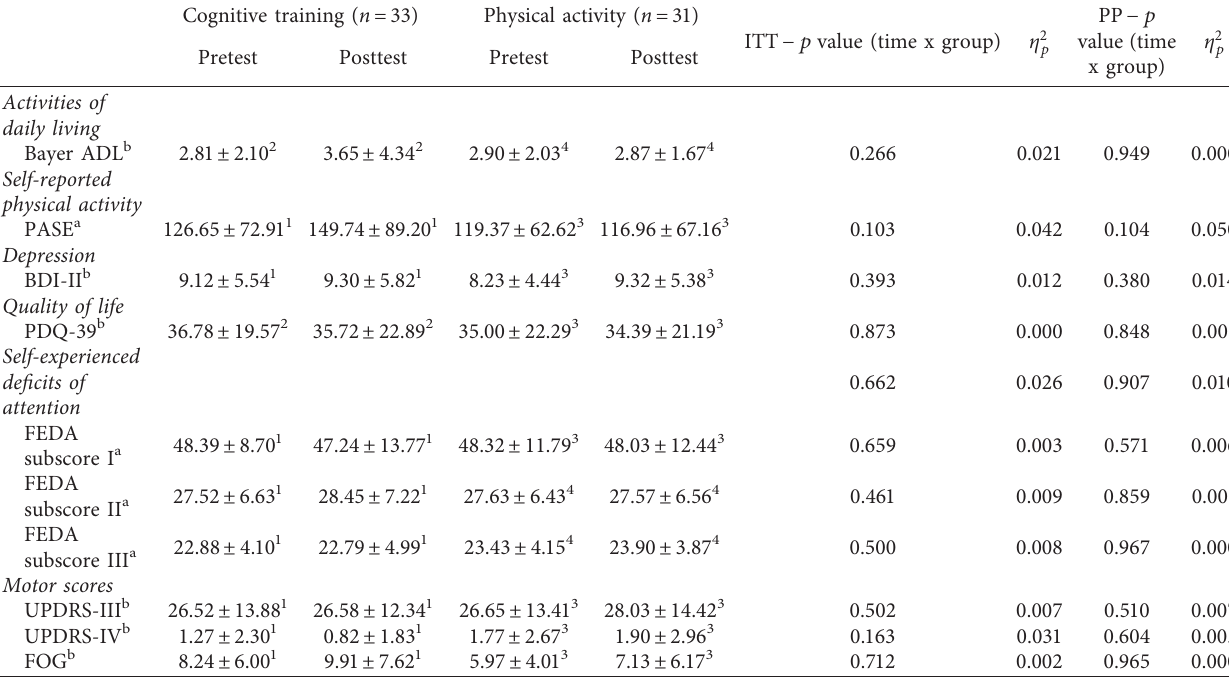
Table 2: Exploratory analysis of training effects for noncognitive outcomes for both groups at the pre- and posttest. Cognitive training ( n �